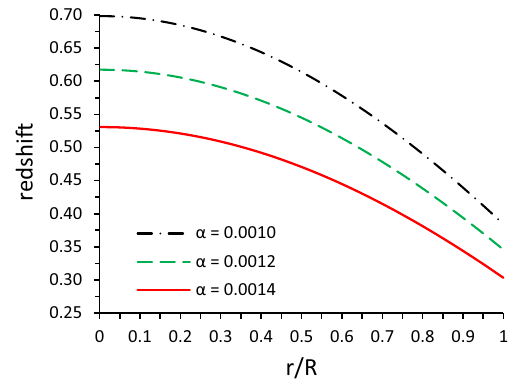
Fig. 3 The variation of gravitational redshift ( z ) verses radial coordi- nate r / R . The same values are taken for plotting of this figure as in Fig.